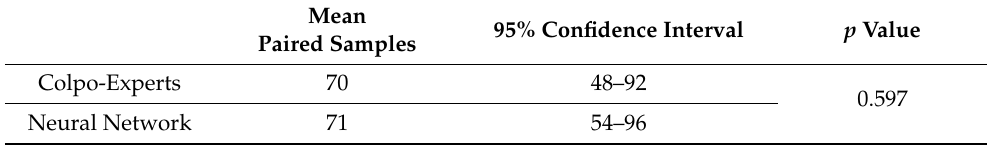
Table 3. Statistical comparison between the visual evaluation experts and the CAD tool.